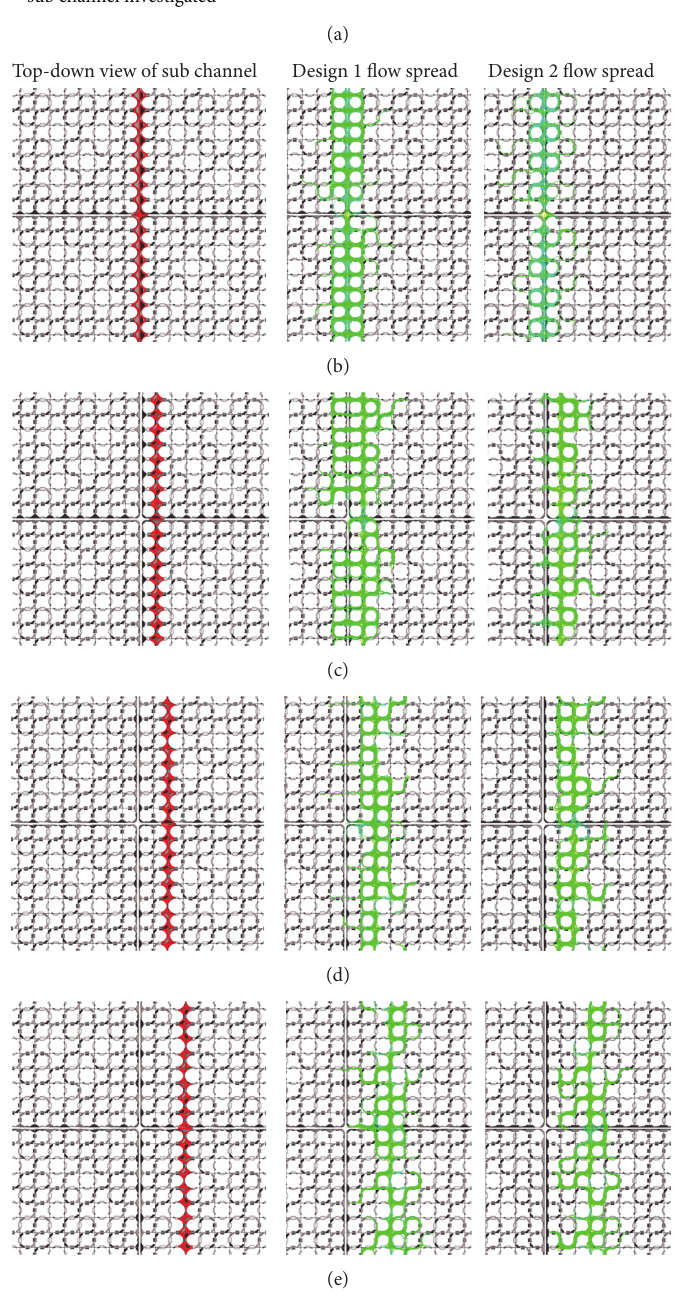
Figure 7: Top-down view of streamline at different subchannels near the outer